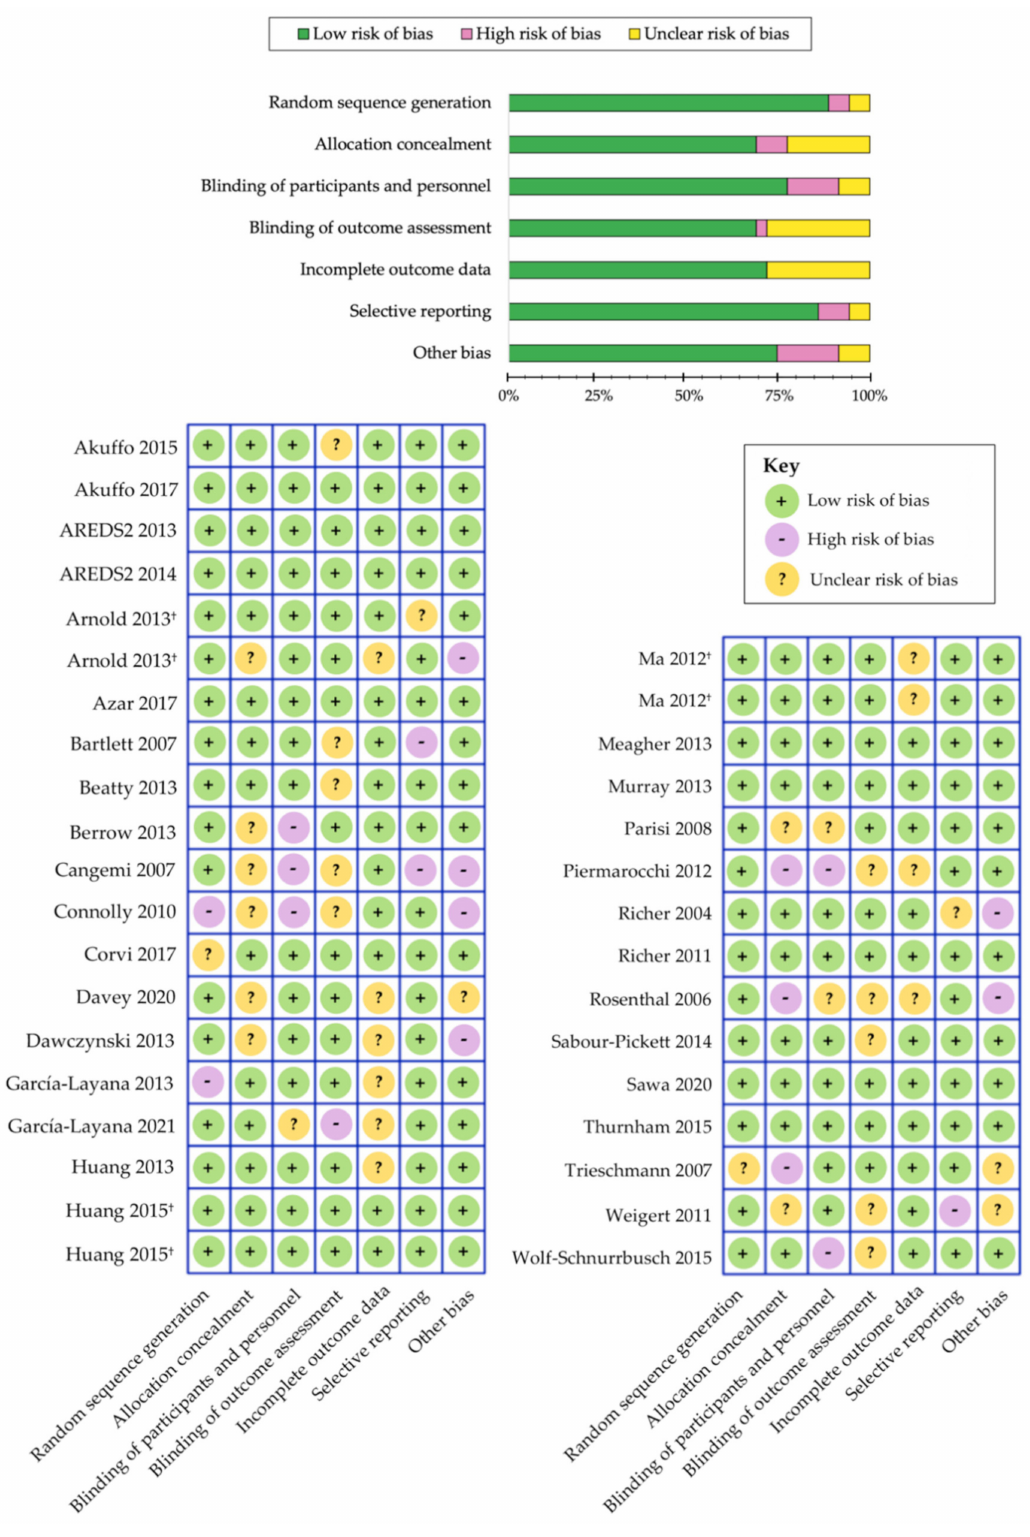
Figure 3. Cochrane Collaboration’s tool for assessing risk of bias in randomized controlled trials [185]. Separate publications are indicated with a symbol (†) next to author